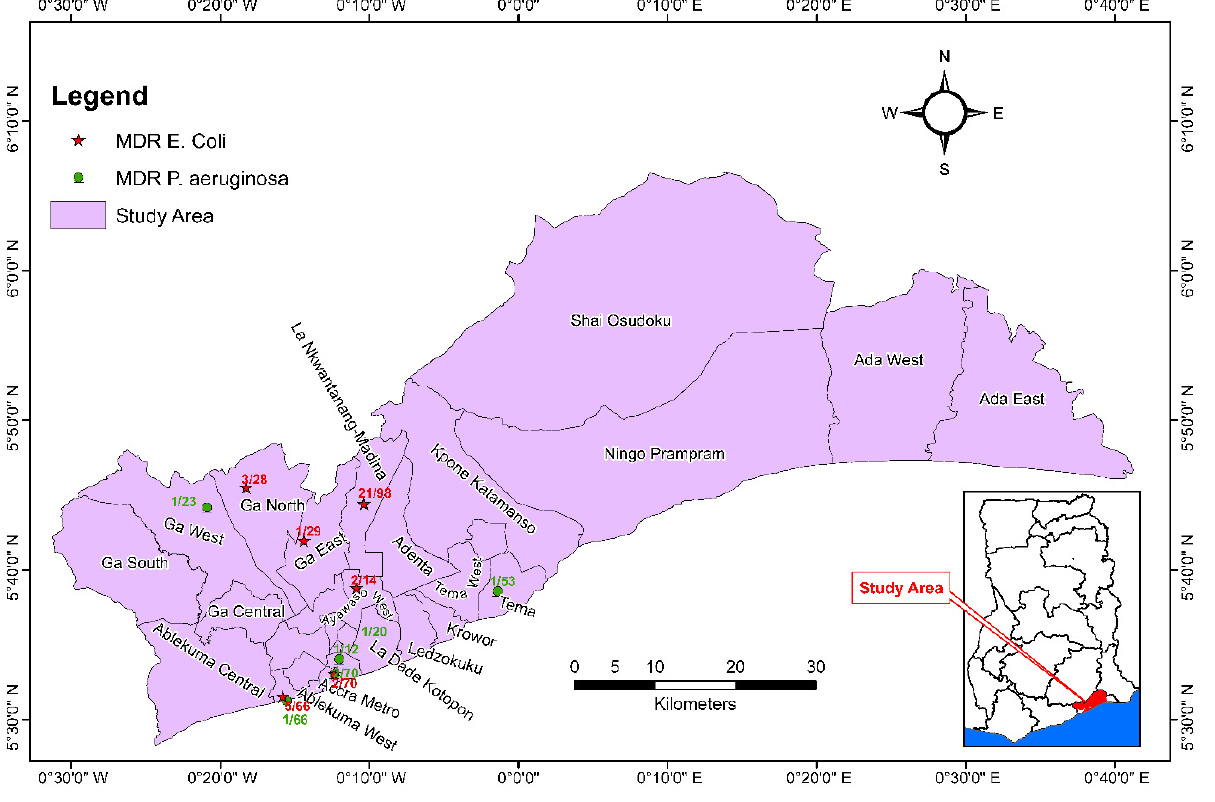
Figure 2. A spot map of Greater Accra region, Ghana showing source locations of MDR E. coli and P. aeruginosa isolates from water samples (December 2021–March 2022). MDR: Multidrug resistance.